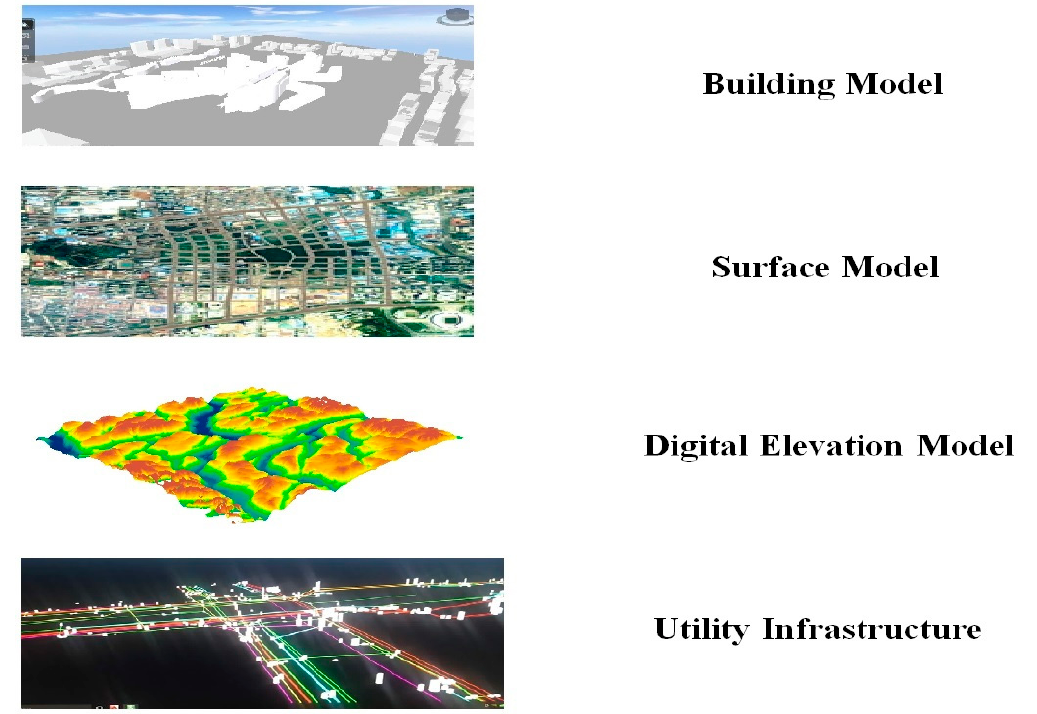
Figure 5. Information stored in di ff erent layers in